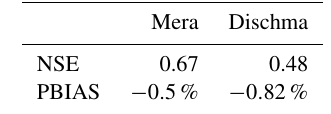
Table 9. Calibration scores for